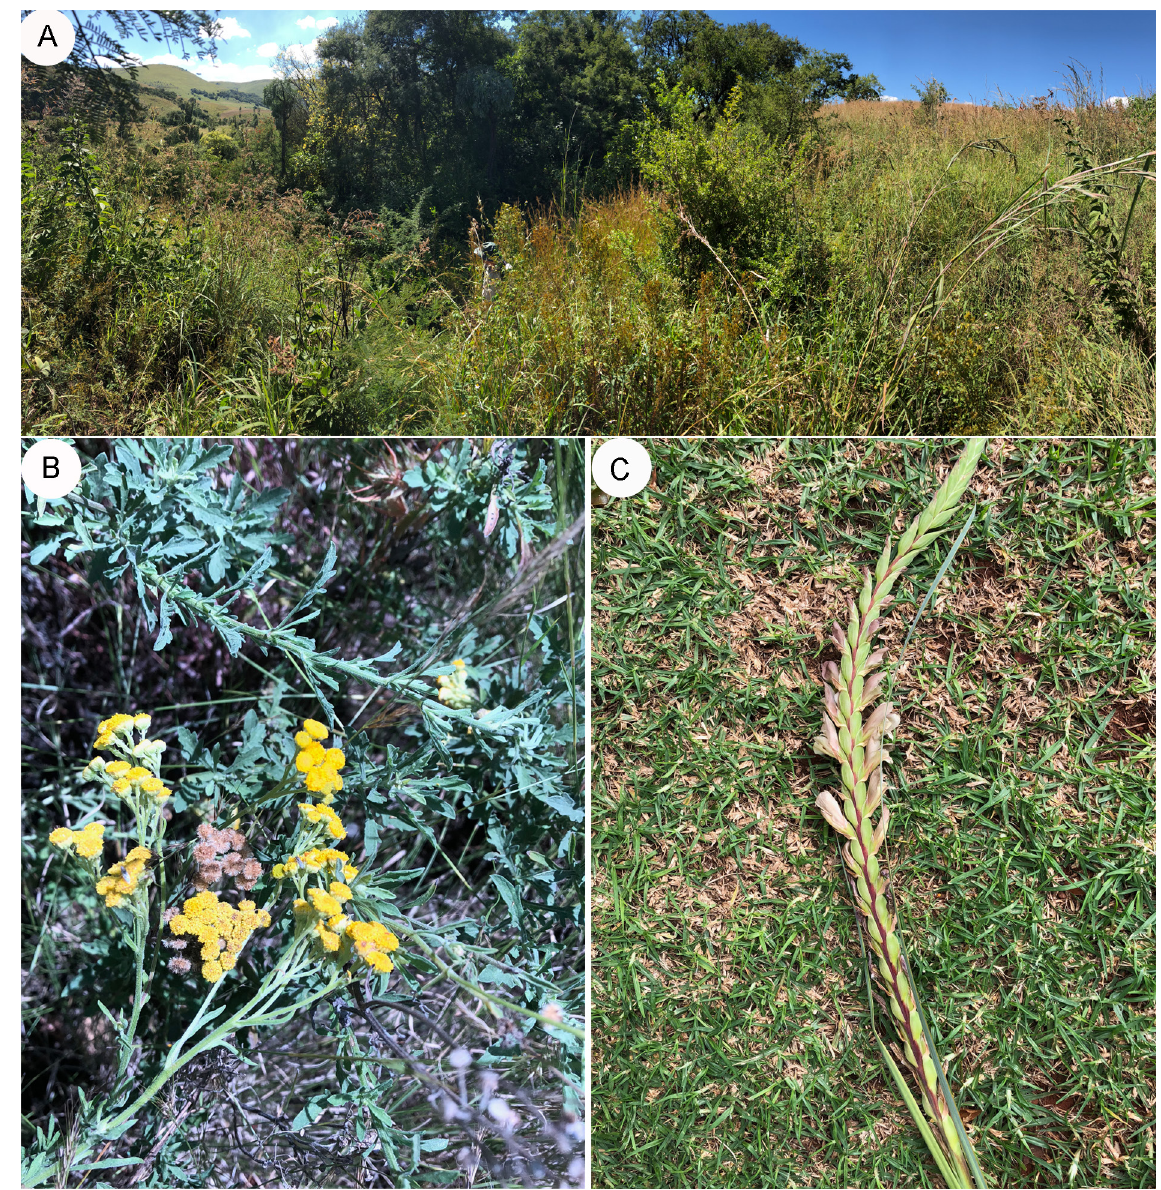
Fig. 25. Habitat of Merodon multifasciatus Curran, 1939. A . Mpumalanga, near Emgwenya (Waterval Boven). B . Nidorella auriculata DC. C . Gladiolus sericeovillosus Hook. Photos by Branka Božičić